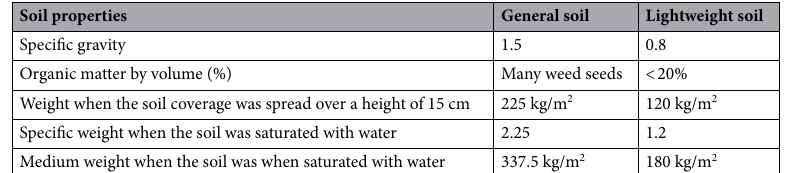
Table 7. Comparisons between different soil types.